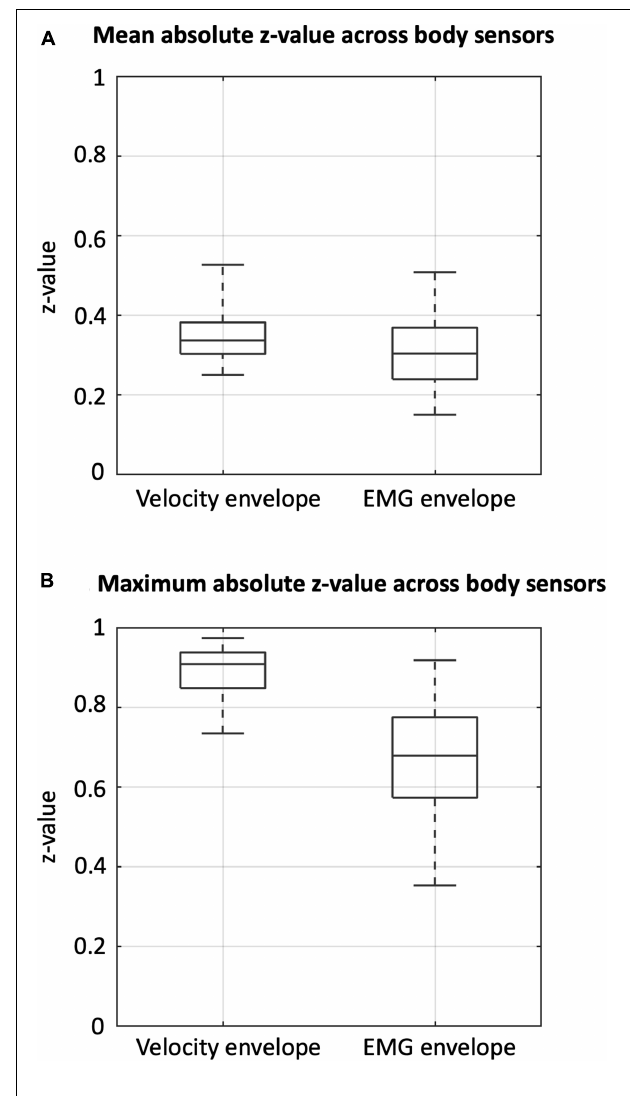
FIGURE 5 | Inter-dependence of velocity and EMG envelopes across body sensors. Box plots indicating (A) the mean absolute z-value and (B) the maximum absolute z-value, for velocity and EMG envelopes,